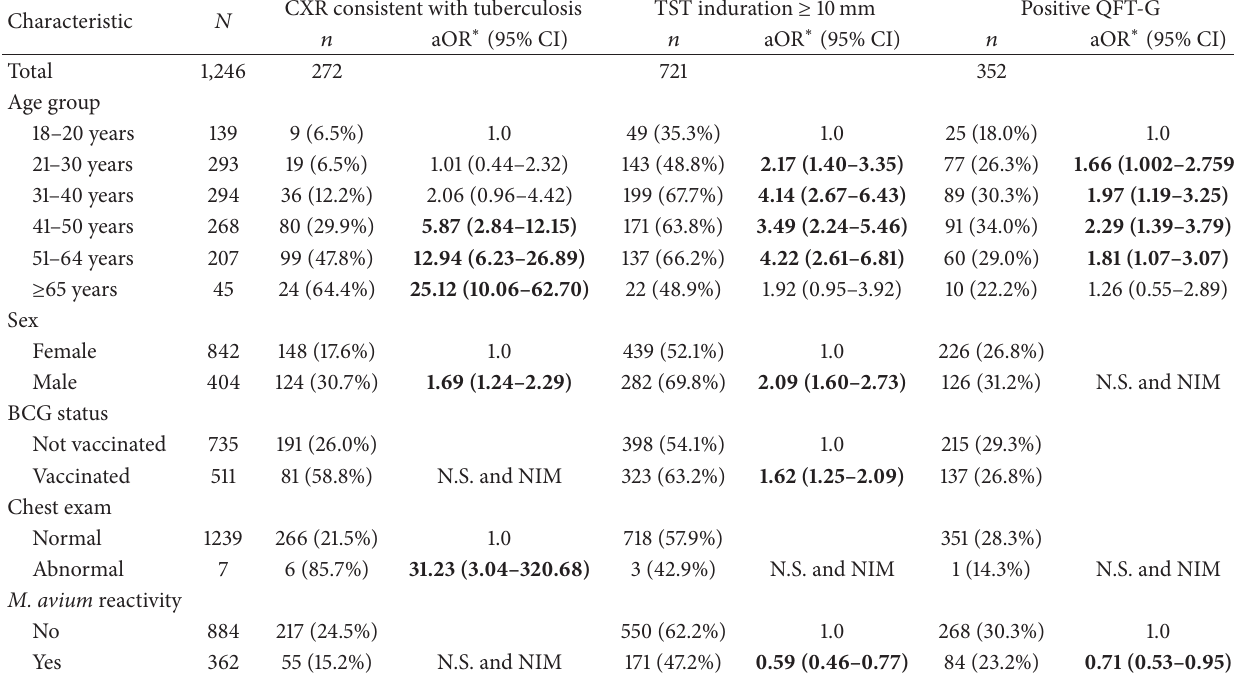
Table 3: Subject characteristics associated with chest radiographs consistent with tuberculosis; TST induration ≥ 10mm; or positive QFT-G results.